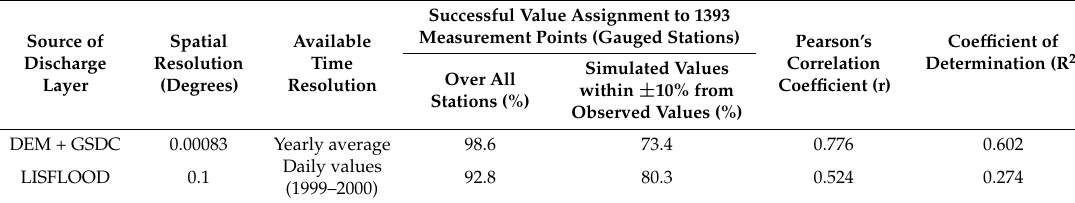
Table 2. Performance assessment of the two simulated discharge layers.